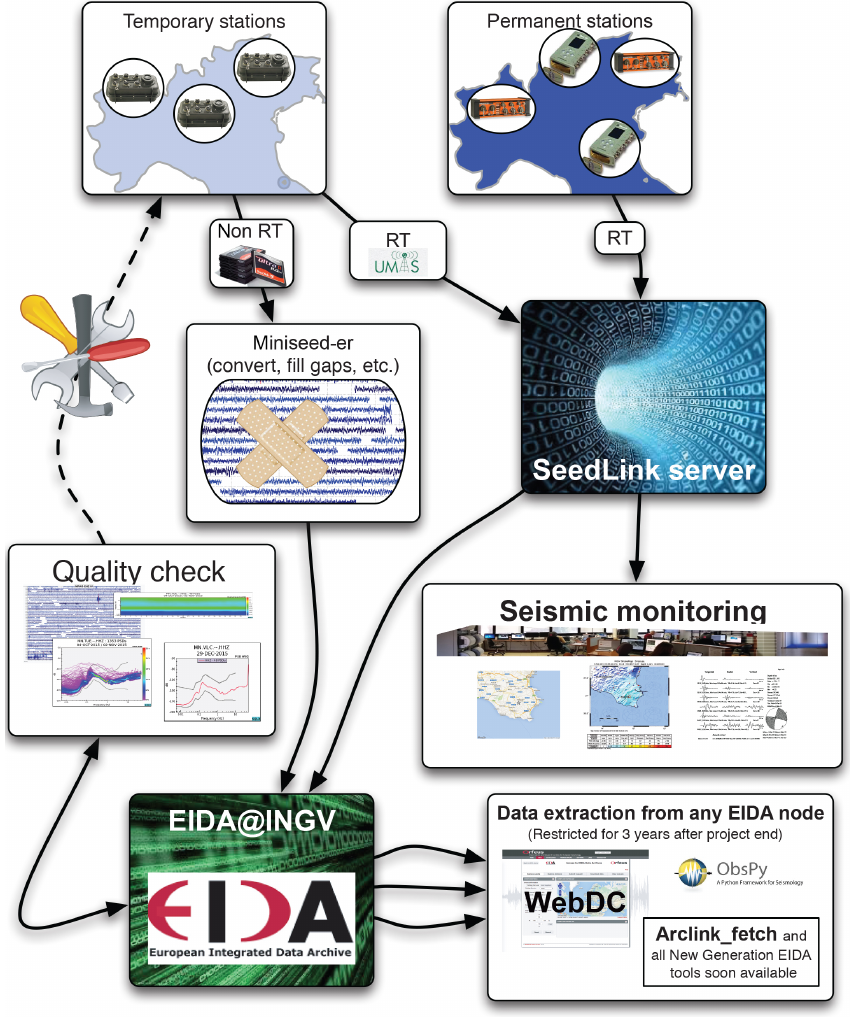
Figure 4. All temporary stations store continuous data in the native REF TEK binary format on Compact Flash support with at least ∼ 8 months of autonomy. Every six months the stations are routinely serviced and the data is collected and processed to obtain a quality checked mini SEED archive that is exported to the INGV EIDA node. All but Z3.A316A (Montecristo) are equipped with UMTS routers and the data is also collected in real-time and made available to the INGV National Seismic Network for monitoring purposes and finally archived on the EIDA node. The State of Health (SOH) real-time data is used to diagnose technical problems to the station power supply, GPS timing system and seismic